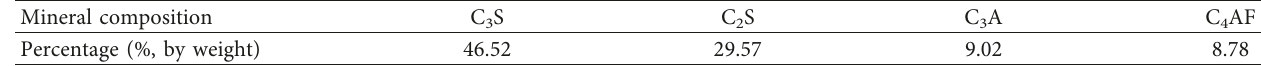
Table 3: Mineral components of mineral powder.